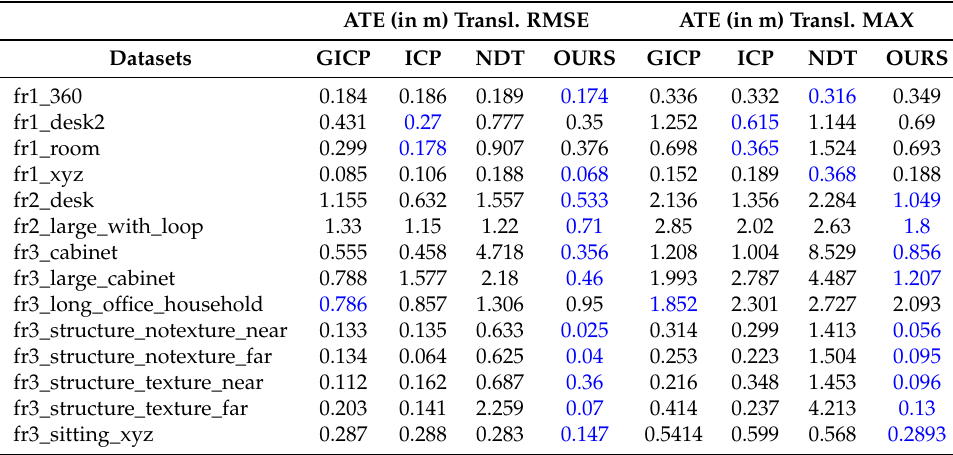
Table 2. Evaluation of GICP, ICP, NDT and ours on tum datasets (The blue number highlights the best results for each specific dataset among all of the compared